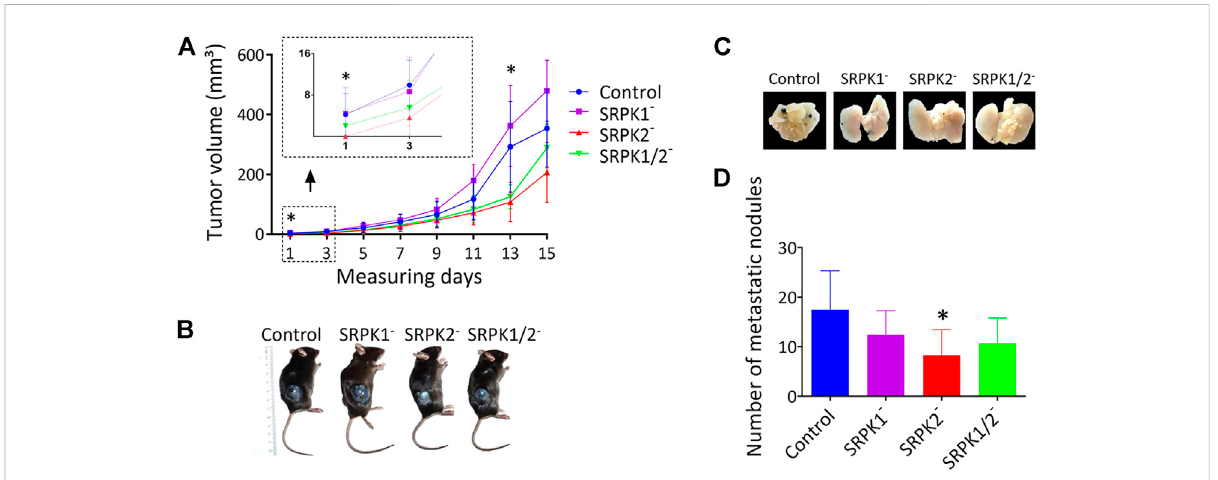
The effects of SRPK genetic targeting on tumor growth in vivo . (A) Genetic targeting of SRPK2 impairs subcutaneous tumor development in mice. The animals were observed daily until the tumor was identi fi ed in the fi rst animals (day 1). The volume of subcutaneous tumors was measured every 2 days for 15 days (B) Representative photographs of tumor formation 15 days after inoculation with B16F10 cells. (C) SRPK2 genetic targeting impairslungnodulesdevelopmentinmice.Representativeimagesofpulmonarymetastaticfociproduced21 daysafterintravenousinjectionof B16F10 cells. (D) Lungs were fi xed in 4% (v/v) paraformaldehyde solution and the number of metastatic nodules on the surface was quanti fi ed. Most of the counted nodules were only visualized with the aid of a magnifying glass due to their small size. The graph shows the number of pulmonary metastatic foci. All results are expressed as the mean ± SD. One-way ANOVA followed by Dunn ’ s test was performed (* p <